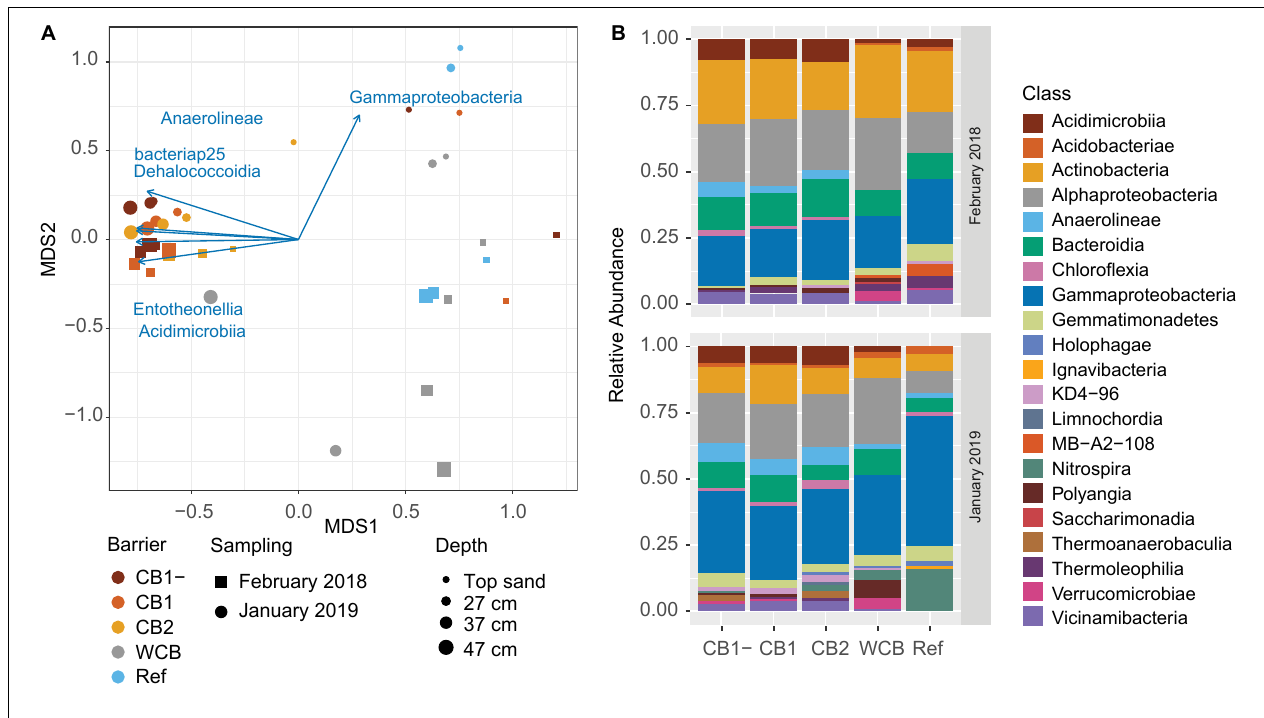
FIGURE 4 | Structure and taxonomic composition of microbial communities in the reactive barrier material. (A) Ordination is based on non-metric multidimensional scaling of Bray–Curtis dissimilarities of OTU abundances (stress = 0.13). Taxonomic classes that significantly correlated with the ordination ( p < 0.05 and r 2 > 0.7) are shown as vectors. The lengths of the vectors are proportional to the strength of the correlation. (B) Mean relative abundances across the depths of microbial classes ( > 2% of the community) in the barriers at the initial and final sampling